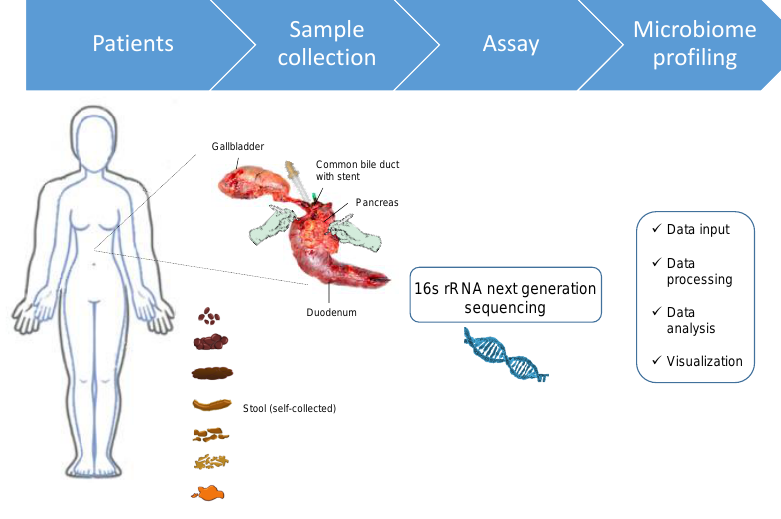
Figure 1. Overview of the study workflow.